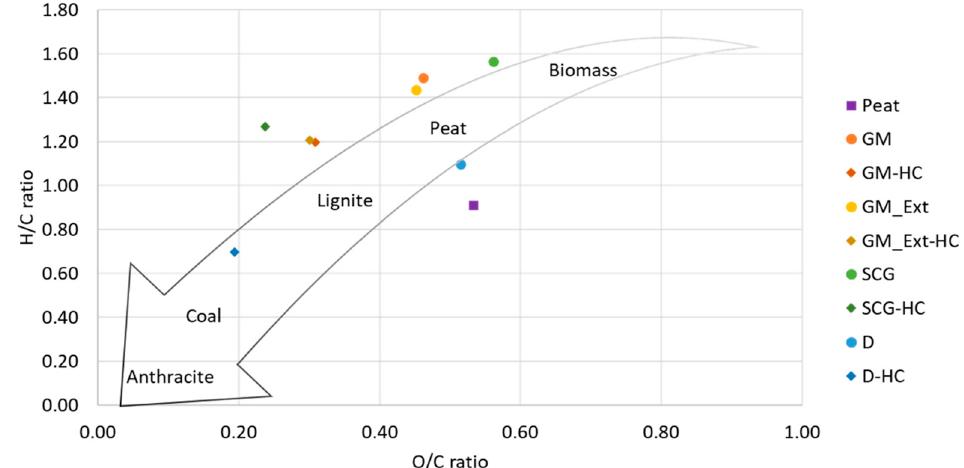
Figure 2. Van Krevelen’s diagram of atomic ratios H/C and O/C for the feedstocks and hydrochars with reference regions for typical organic materials [19,21]. Table 2. C:N ratio of feedstocks and hydrochars.